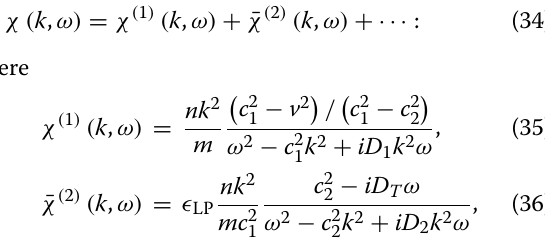
Fig. 13c for first sound and Fig. 13d for second sound at T = 0.84 T c . The density fluctuation should take the form,